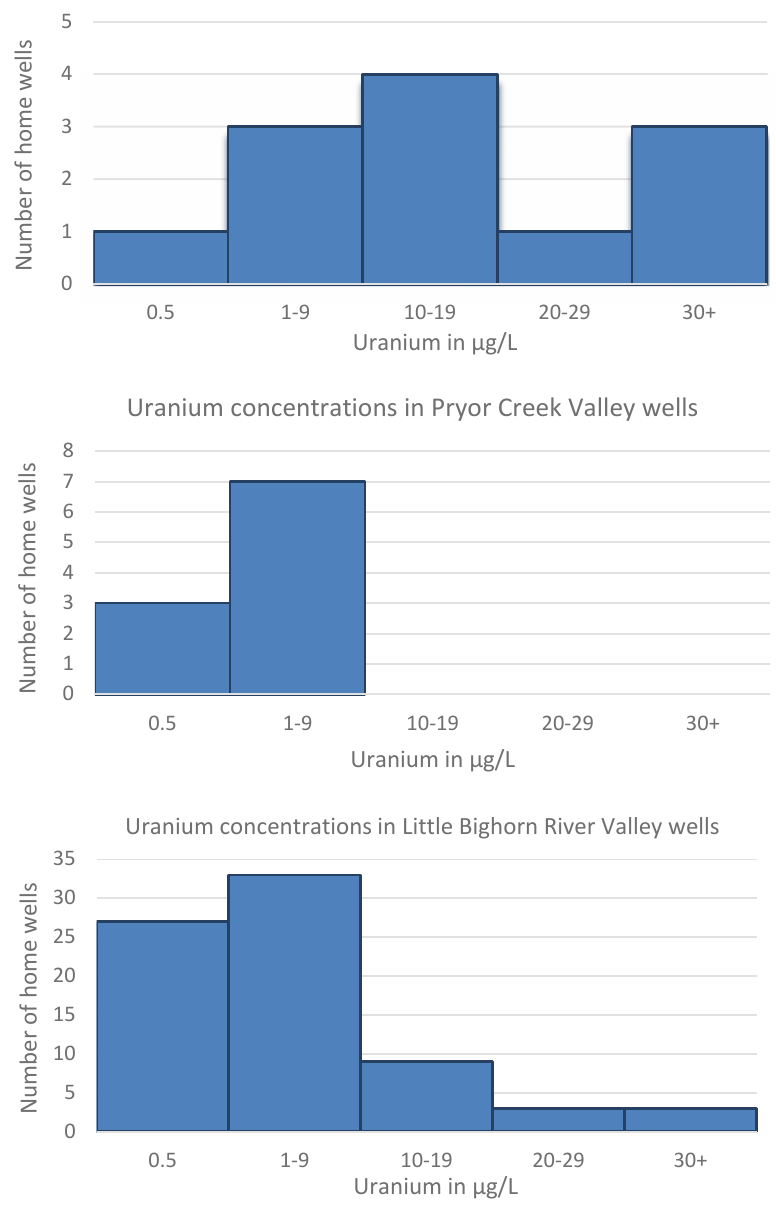
Figure 7. Histograms of uranium concentrations in well water (in μ g/L) by river valley, Crow Reservation. The reporting limit is 1.0 μ g/L, hence 0.5 μ g/L represents